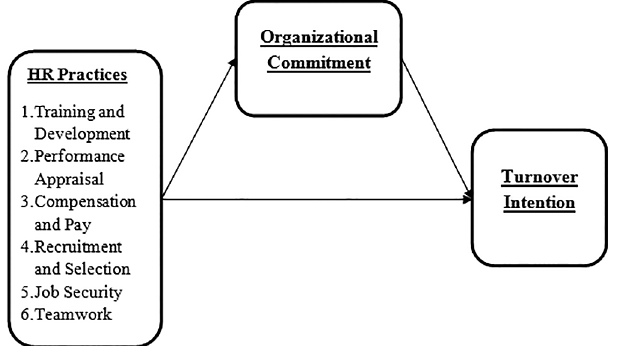
Figure 1. Research